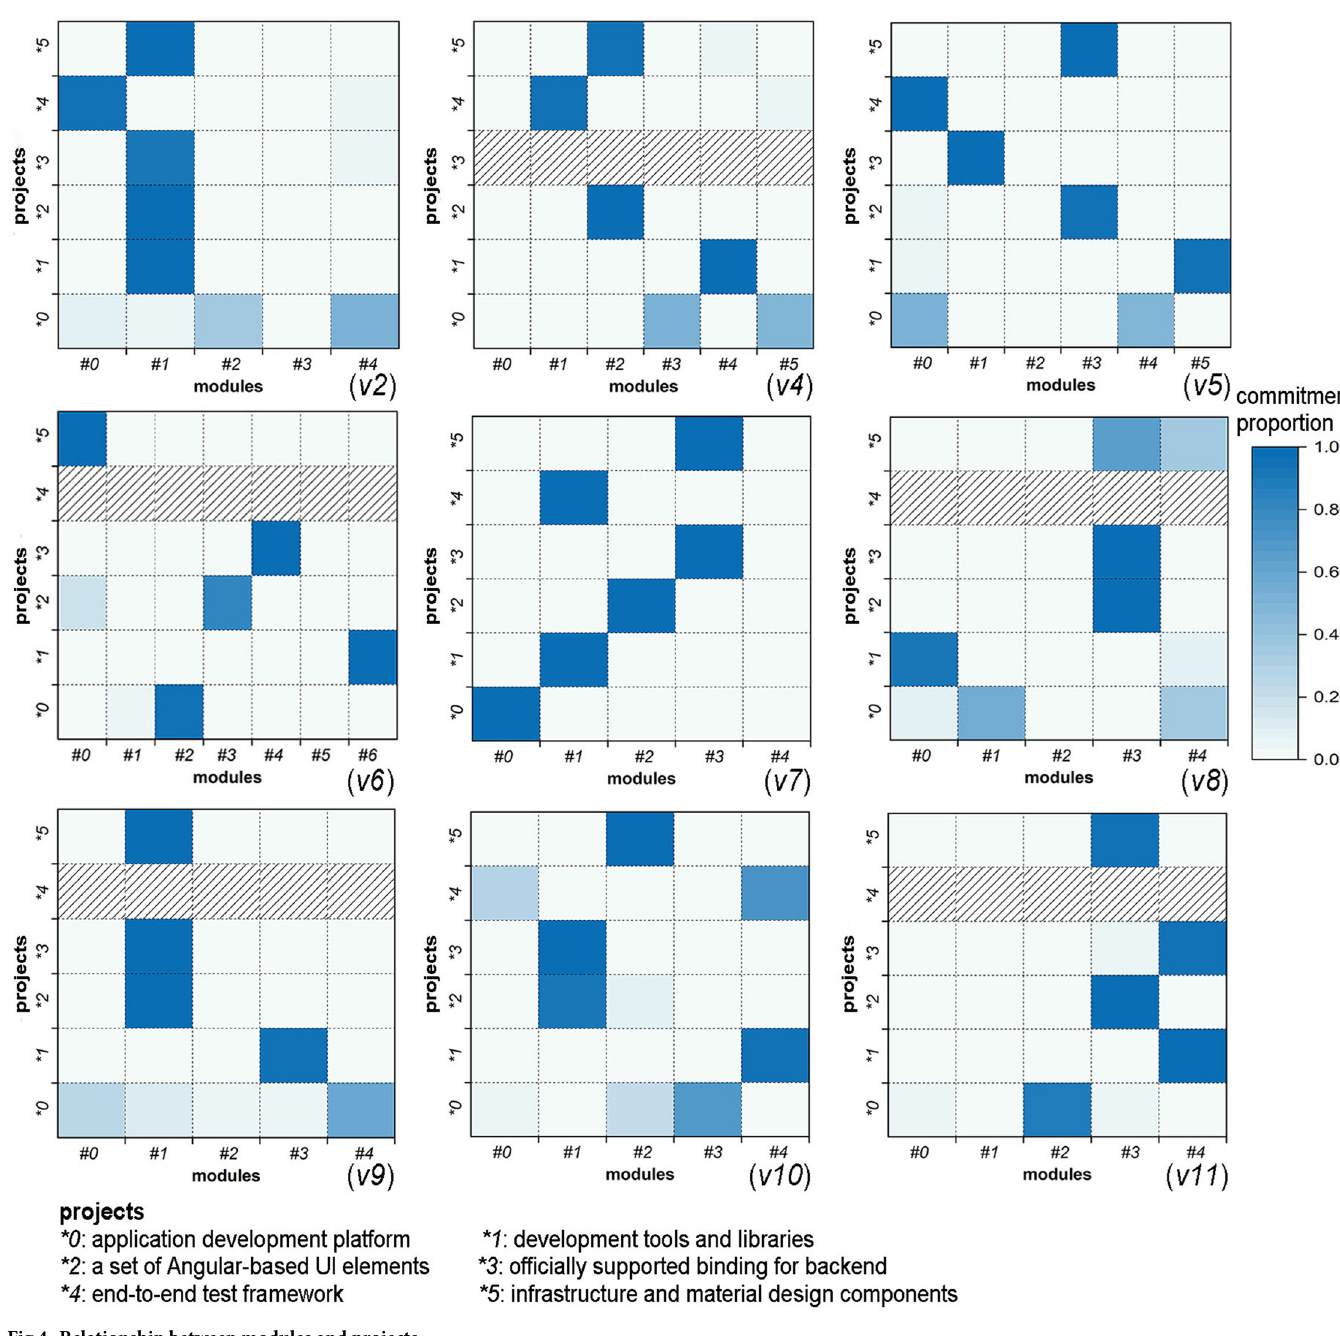
studies show that the small-world structure of different networks (e.g., neural networks, com- munication networks, and transportation networks) is efficient at the local and global levels [19, 31]. The efficiency between a pair of nodes is defined as the smallest sum of the physical distances throughout all the possible paths between them (i.e., the reciprocal of the shortest distance between the nodes). Correspondingly, the global efficiency of a network G (denoted